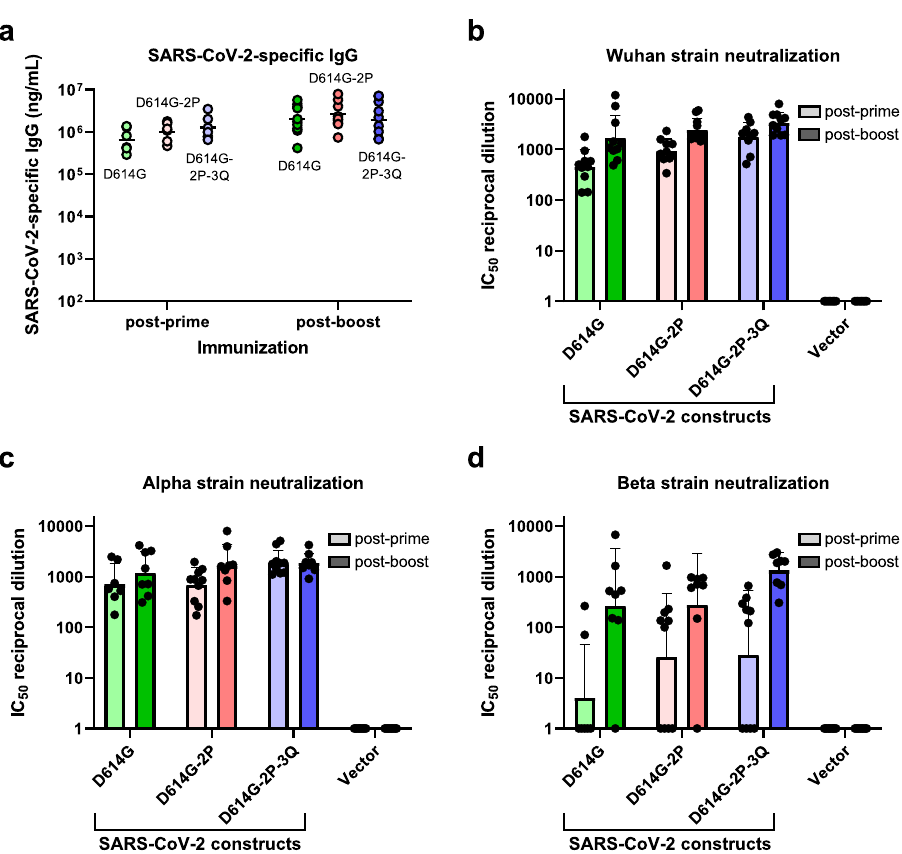
Fig. 3 Immunogenicity of SARS-CoV-2 D614G, D614G-2P, and D614G-2P-3Q saRNA/NLC vaccines after 10 µg prime or prime-boost immunization of C57BL/6J mice. a Serum SARS-CoV-2 spike protein-binding IgG. Horizontal lines show geometric mean. b – d Serum SARS- CoV-2 neutralizing antibody titers against the original Wuhan, Alpha (B.1.1.7), and Beta (B.1.351) pseudovirus variants. The vector control represents mice injected with 10 μ g of NLC-complexed saRNA expressing the non-immunogenic secreted embryonic alkaline phosphatase gene. Results show geometric mean and geometric standard deviation. n = 10 mice per